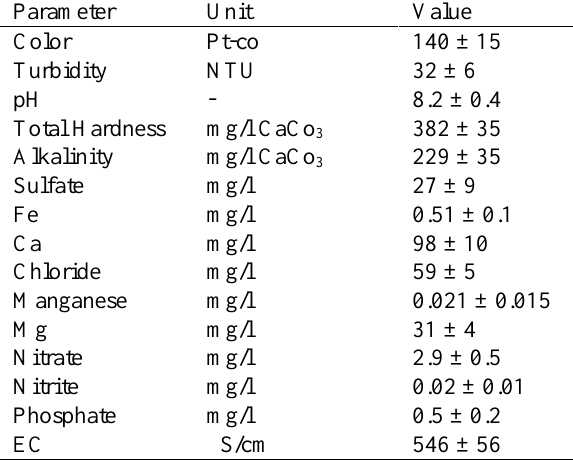
Table 1. Water quality studied